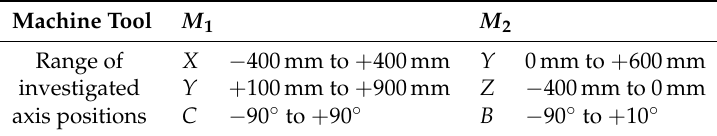
Table 1. Range of the investigated axis positions for both machine